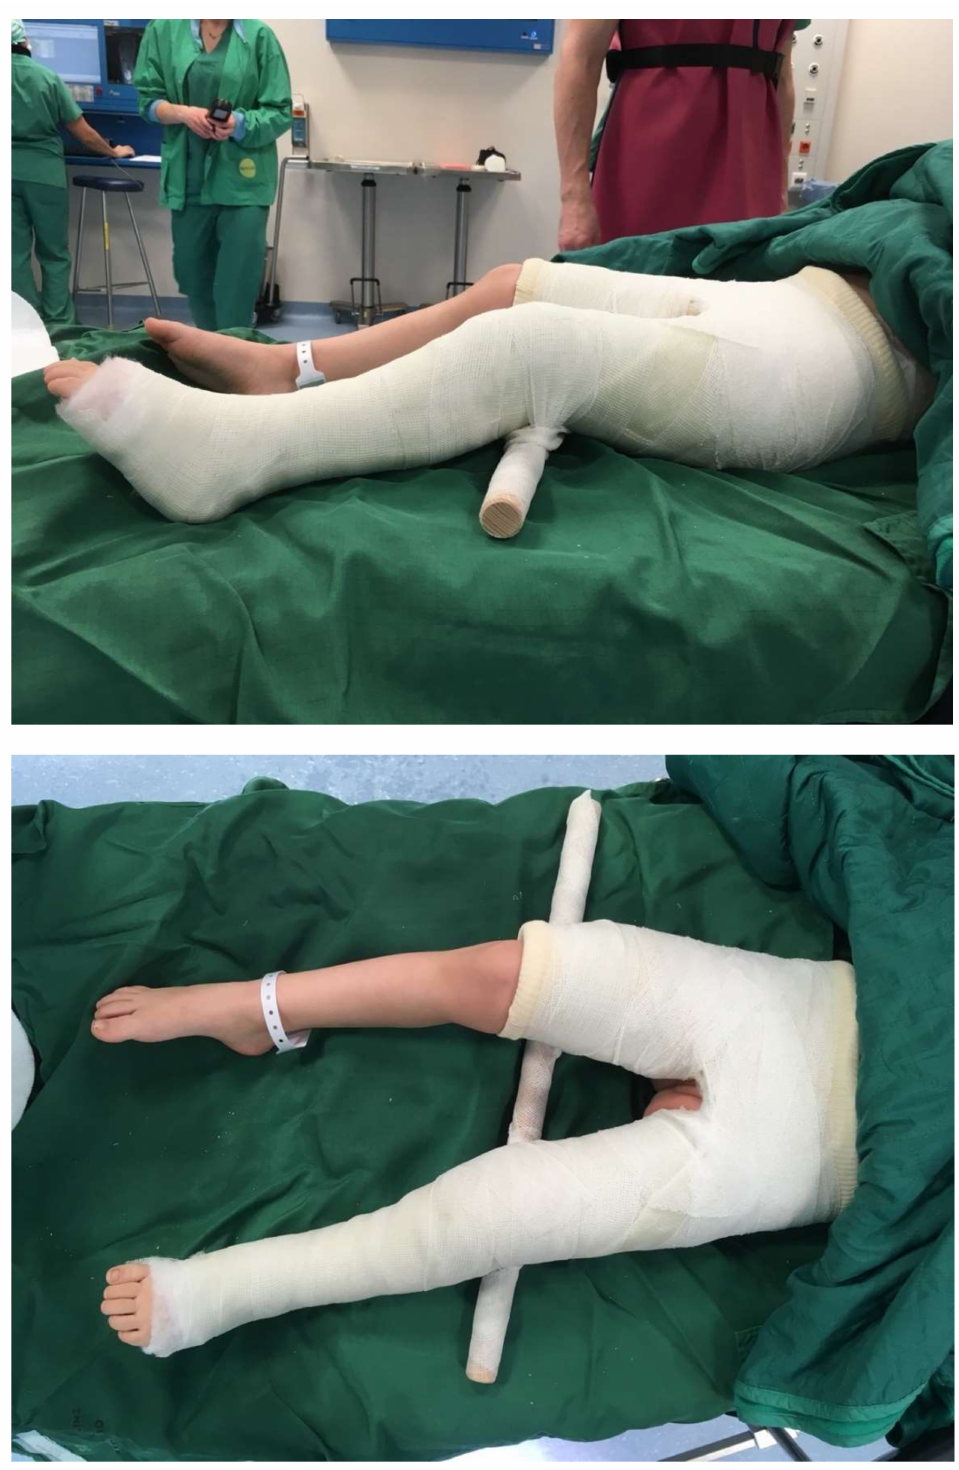
Figure 2. Postoperative spica